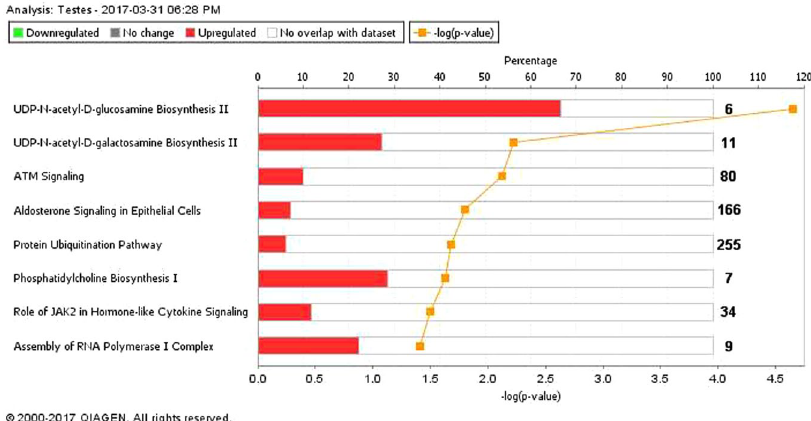
Figure 4. Biochemical pathways statistically significantly enriched in the testes of Holstein-Friesian bull calves offered either a fed on low or a high plane of nutrition and, slaughtered at 18 weeks of age. Green and red bars represent genes down and up regulated, respectively, as a percentage of the overall number of genes in each pathway. The significance of each pathway is represented by the yellow line describing − log(p-value). The P-value is calculated by the number of genes from our dataset of differentially expressed genes represented in a particular pathway, divided by the total number of genes in the Canonical Pathway in IPA analysis. Data were analyzed through the use of IPA (QIAGEN Inc., https://www.qiagenbioinformatics.com/products/ ingenuitypathway-analysis) 51